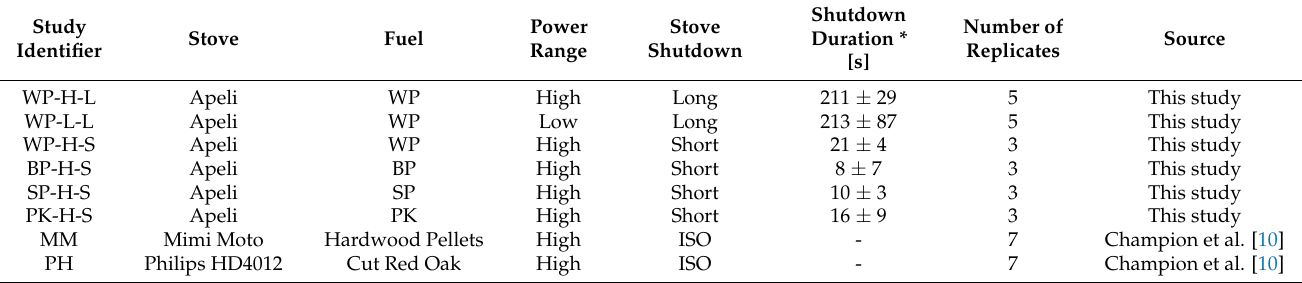
Table 2. Experimental matrix for modified ISO measurements using different fuels, loads and stopping criteria in addition to data from other studies for comparison; stove shutdown criteria are explained in Section 3.5.1 (long) and Section 3.5.2 (short)—ISO: according to ISO 19867-1:2018